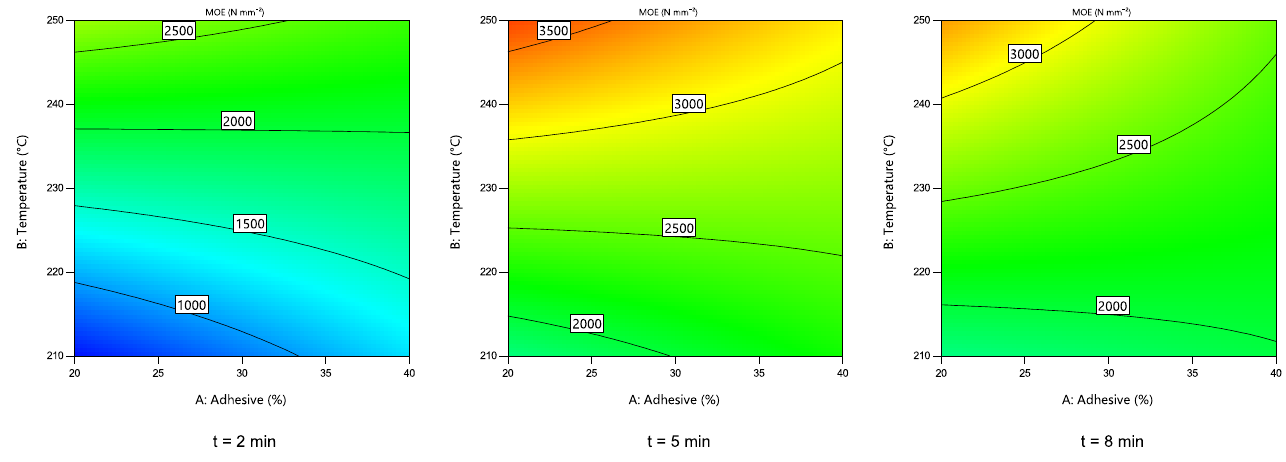
Figure 5. Changes in the MOE value of the boards depending on the hot-pressing parameters.